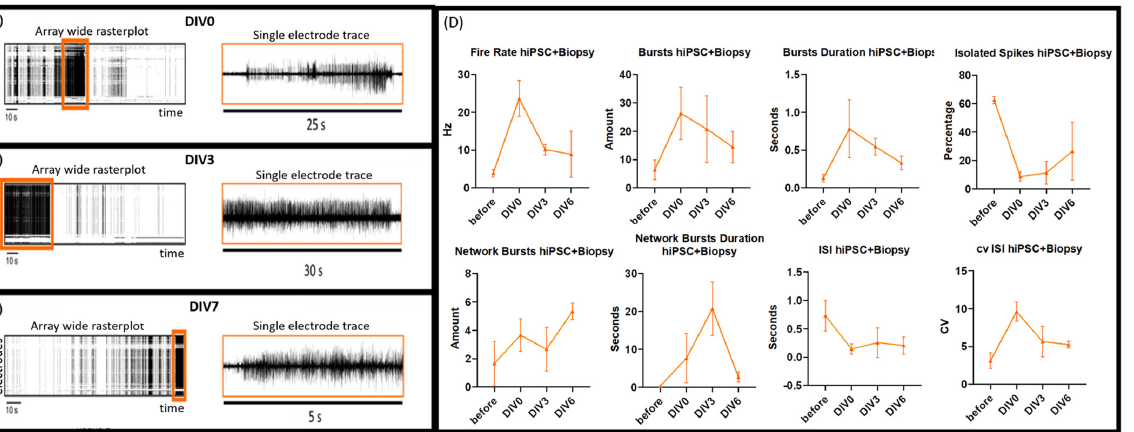
Figure 4. Electrophysiological recordings of the hybrid model one hour after assembly (DIV0) ( A ); at DIV3 ( B ) and at DIV6 ( C ). The left of each panel shows an array-wide rasterplot (120 electrodes on the Y-axis vs. time in seconds (s) on the X-axis), from which some epileptiform phenotypes were extracted (orange rectangles). The right of each panel represents a single-channel trace from the corresponding timeframe at a higher temporal resolution, showing voltage activity. This suggests that burst activity of 25 − 30 s can be detected for up to 3 days after resection of the biopsy and diminishes to bursts of 5 s by culture day 6; ( D ) Electrophysiological characterization (fire rate, burst rate and durations, isolated spikes, network bursts and durations, as well as ISI and cv of ISI) of the hybrid model, with hiPSC neuronal derived cultures (DIV16) measured before and after biopsy assembly for 6 days (hiPSC + Biopsy, orange). Error bars represent mean with SEM of three 2 min recordings per condition.